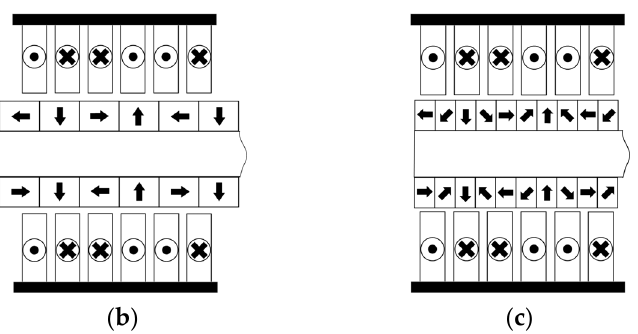
Figure 3. Electromagnetic structure of the electromagnetic actuator.